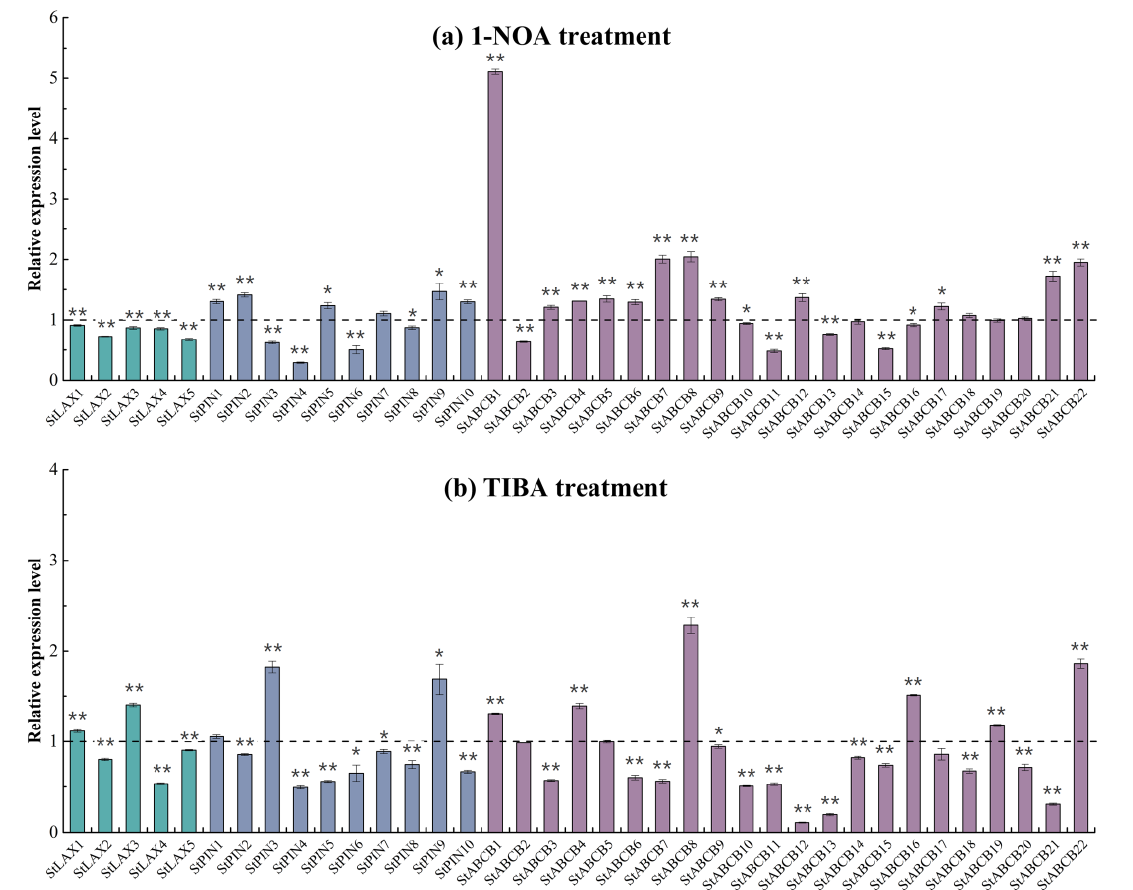
Figure 7. Expression profiles analysis of auxin transporter genes StLAX, StPIN, and StABCB under auxin transport inhibitor treatments. Potato plantlets grown at four − weeks − old were treated with 30 µ M 1 − naphthoxyaceticacids (1 − NOA) ( a ) or 50 µ M 2,3,5 − triiodobenzoic acid (TIBA) ( b ) for 3 h. The relative expression levels were normalized to a value of 1 in the untreated seedlings. Assays were run in triplicate, and bars represent SDs. (* t -test p -value < 0.05, ** t -test p -value < 0. 01.)